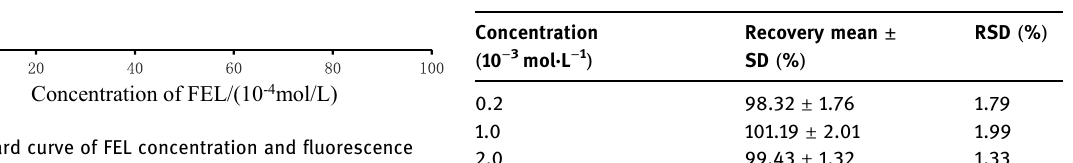
Table 3: Experimental results on the accuracy of probe